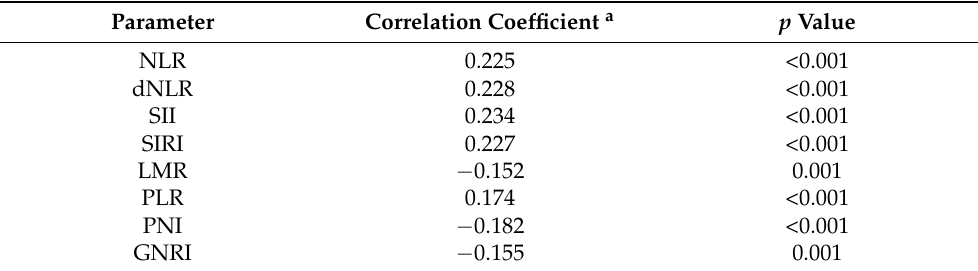
Table 3. Correlations between the inflammatory and nutritional parameters and the pathological tumor